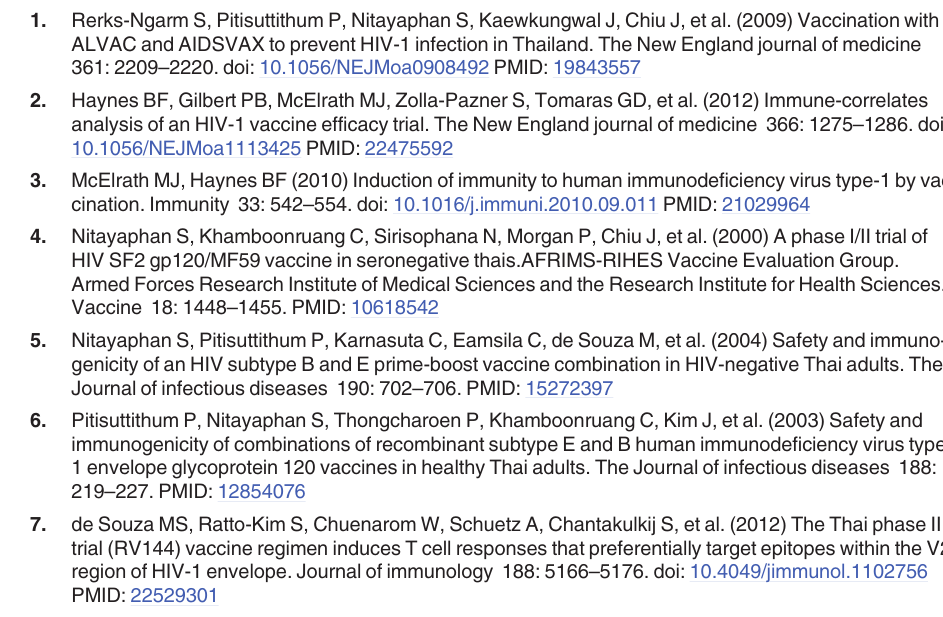
S2 Table. ELISpot data used in the peptide titrations graphs. S3 Table. Percentages of intracellular cytokine staining produced by CD4+ T cell lines in response to a set of peptides that include sieve mutations or mutations that were observed in the breakthrough infection from the RV144 trial. The first two tabs represent two experi- ments using in part the same peptides. The third tab show the summary of the analysis. S4 Table. Antibody binding measurements. The Table shows duplicate readings of absor- bance measured at 450 nm for the same volunteers that envelope specific CD4+ T cell lines were